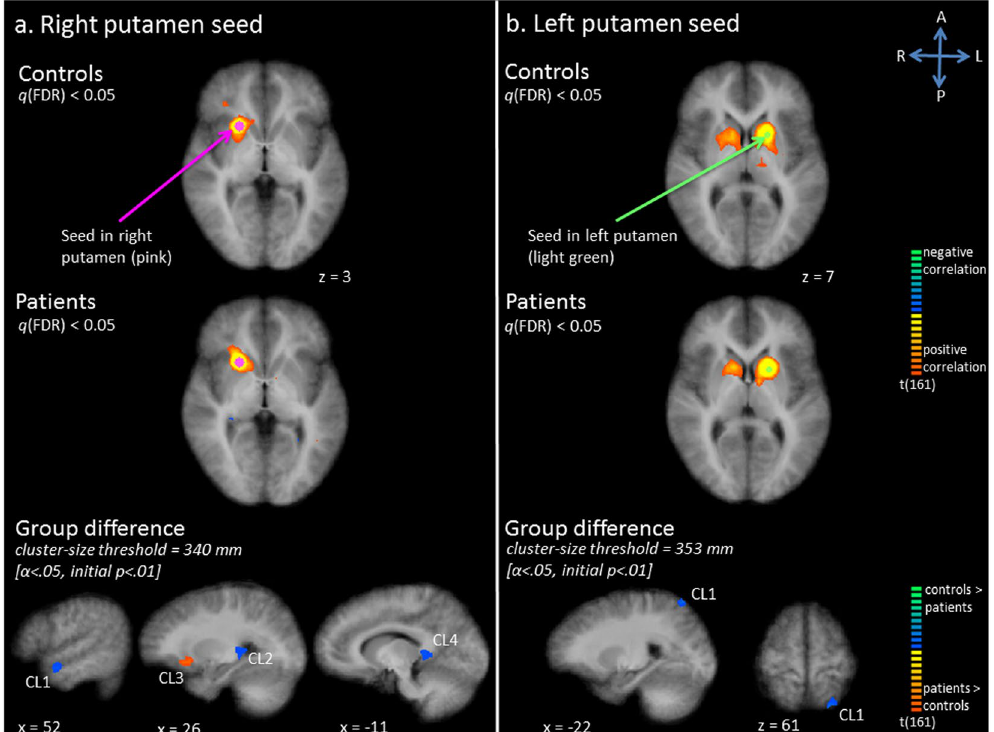
Figure 2. Functional connectivity (Fc) maps for the putamen seed; panel a: right putamen seed, panel b: left putamen seed. Upper and middle row: Statistical maps resulting from the seed-based correlation analysis separate per group. Seeds are overlaid in pink (right putamen seed) or light green (left putamen seed). Maps are thresholded at q (FDR) < 0.05. Lower row: Group differences in functional connectivity per seed region (red indicates patients show increased connectivity as compared to controls, blue indicates patients show decreased connectivity as compared to